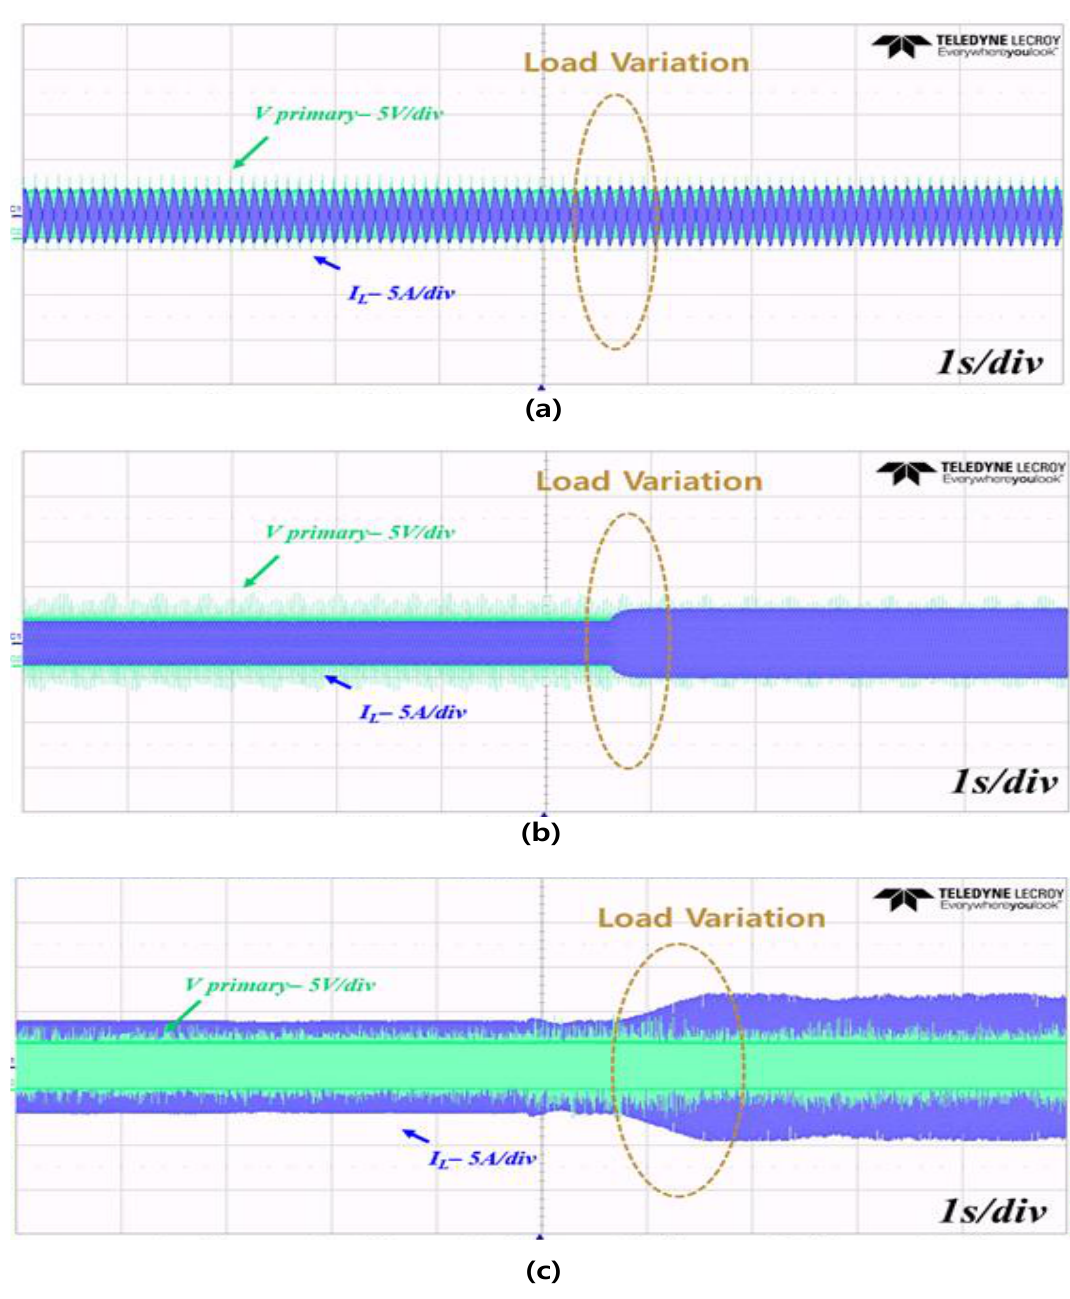
Figure 18. Wave of primary voltage and current ( d = 5 cm, Ro = 10~20 ohm); ( a ) zero voltage switching (ZVS) operation without proposed frequency tracking algorithm; ( b ) zero current switching (ZCS) operation without proposed frequency tracking algorithm; ( c ) zero phase angle (ZPA) operation with proposed frequency tracking algorithm.